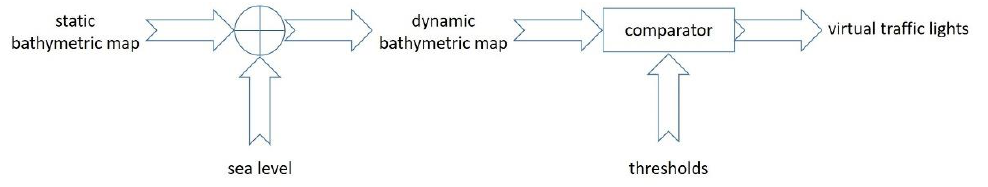
Figure 5. Block diagram of bathymetry updating and virtual traffic lights.